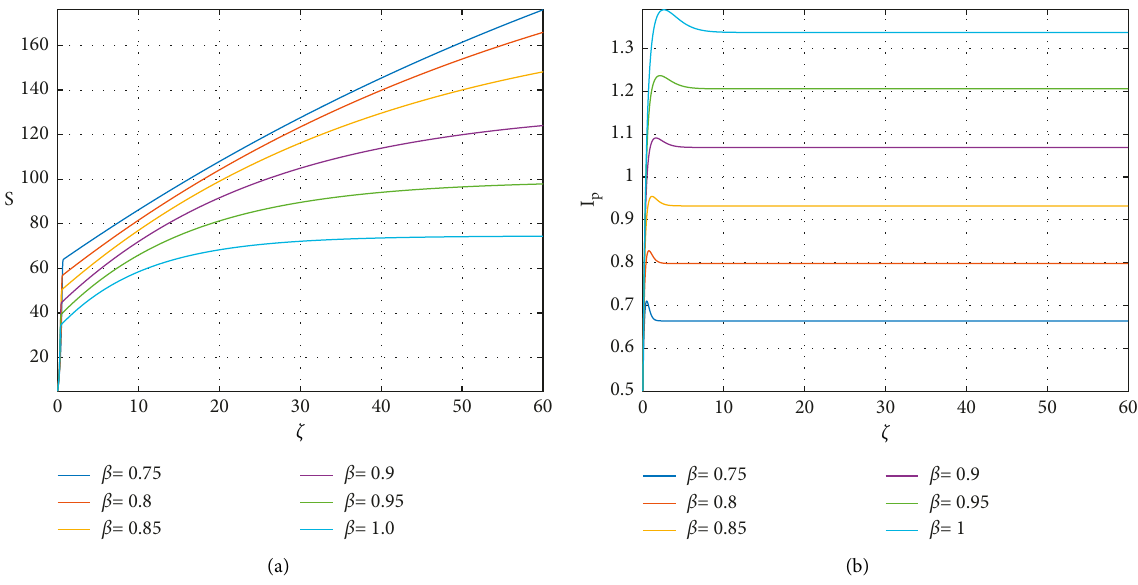
Figure 8: Two-dimensional illustration of the susceptible class S and pneumonia infectious I fractional orders β ∈ [ 0 , 1 ] .